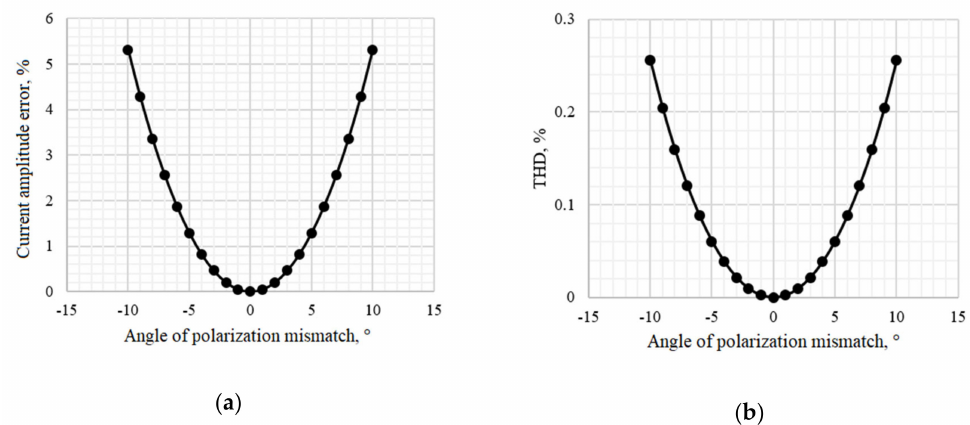
Figure 16. Dependences: ( a ) Current amplitude error vs. angle of polarization mismatch at point 8; ( b ) The total harmonic distortion vs. angle of polarization mismatch at point